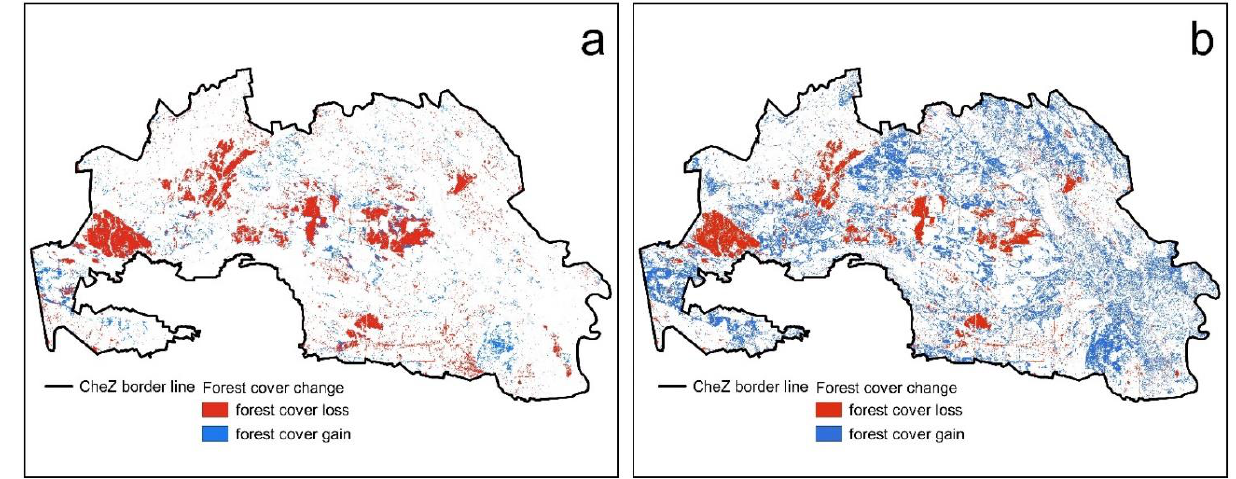
Figure 9. ( a ) Global Forest Change (GFC [1]) data vs. ( b ) our forest cover change product for the period 2000 – 2020.